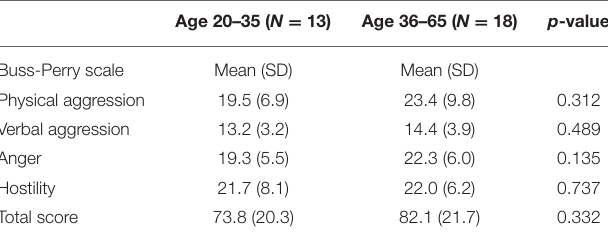
TABLE 4 | Buss Perry scores in our cohort categorized by